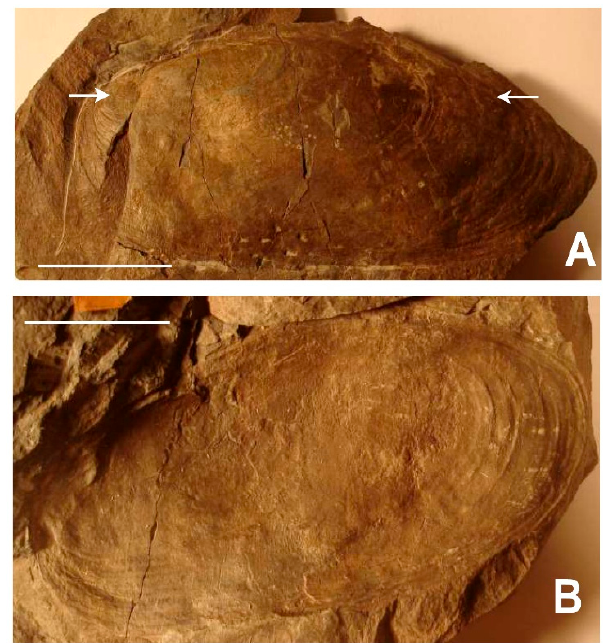
Figure 5. Shell form of Archanodon catskillensis . Two different specimens preserved on a slab of hard siltstone now held in the invertebrate fossil collections of the American Museum of Natural History (AMNH), New York, which Hall [2] used to define his Amnigenia catskillensis . The slab is labeled AMNH FI 006331, and is noted as having been collected near Oneonta, New York. ( A ) Shell impression with adductor muscle scars indicated by white arrows; ( B ) Shell impression with exposed hinge line lacking obvious hinge teeth. Anterior to the left in both specimens. Scale bars = 3 cm in both ( A , B ).